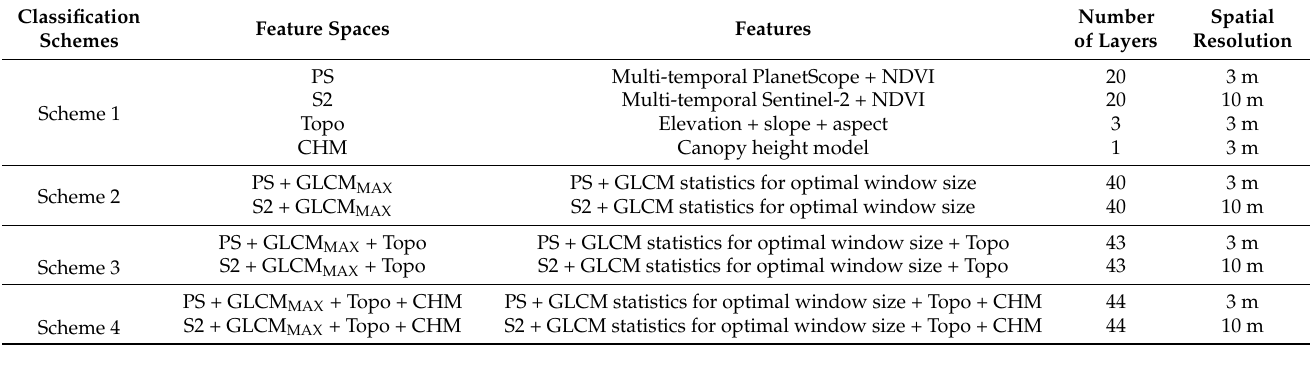
Table 1. Classification schemes and feature space description.